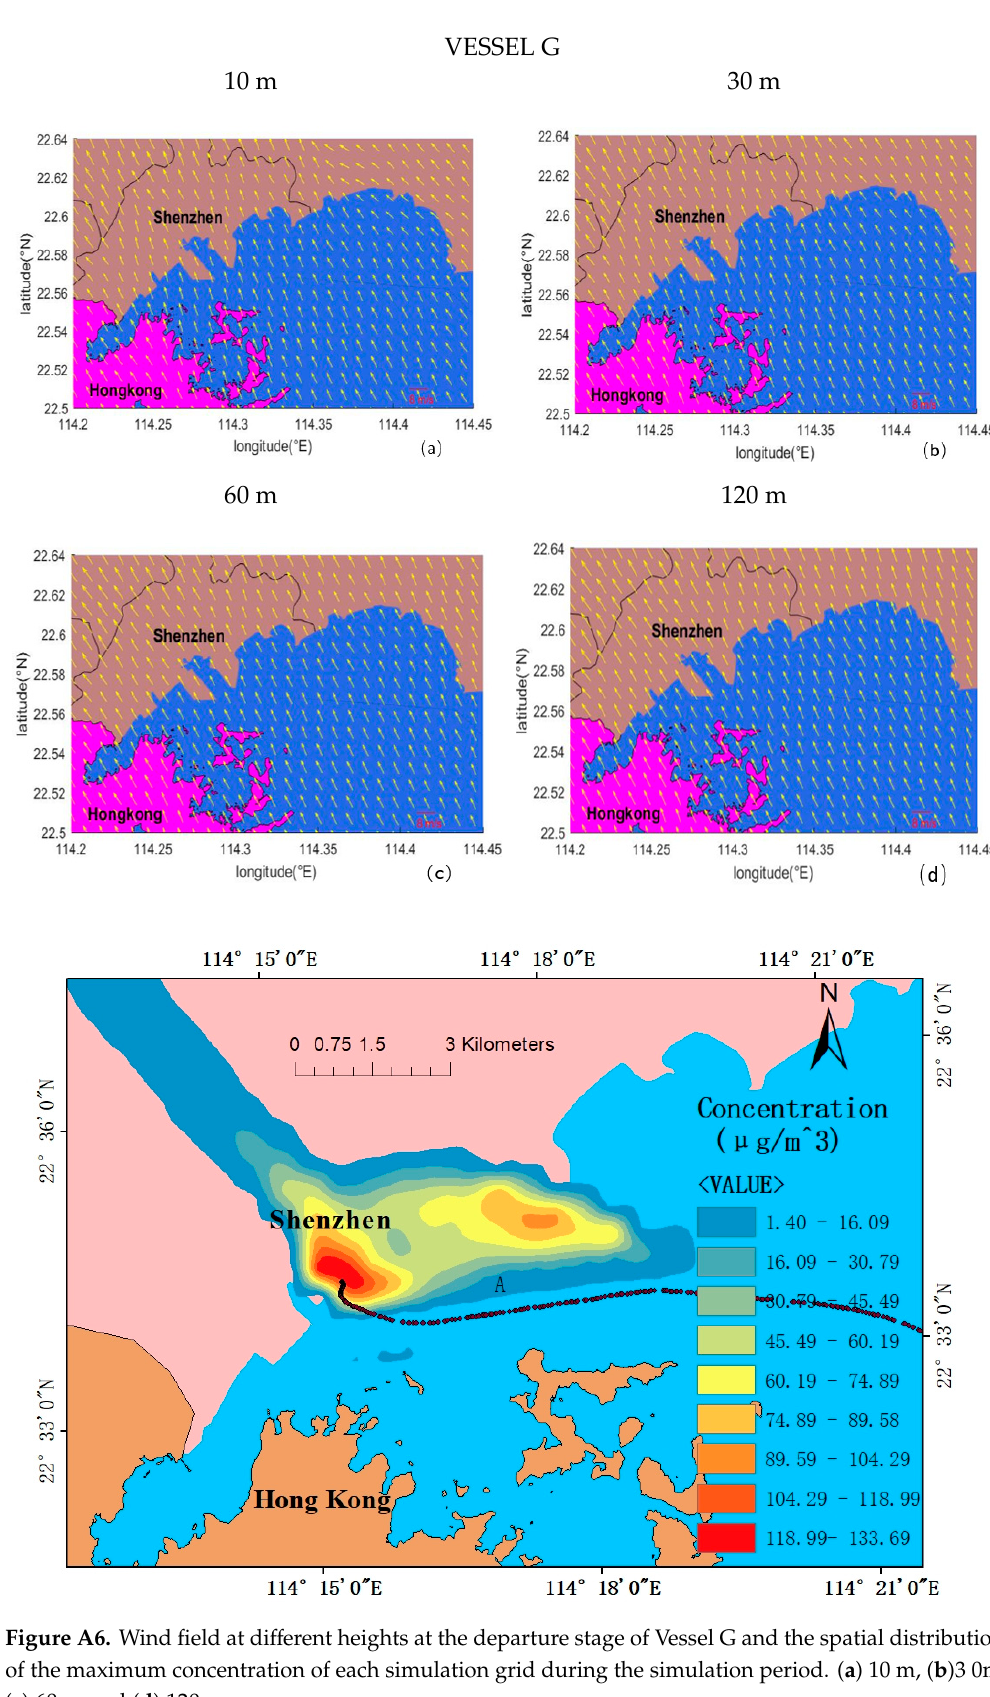
Figure A6. Wind field at different heights at the departure stage of Vessel G and the spatial distribution of the maximum concentration of each simulation grid during the simulation period. ( a ) 10m, ( b )3 0m, ( c ) 60m and ( d ) 120m.